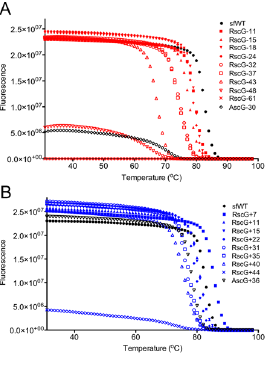
Figure 9. Stability measurements using thermal denaturation while monitoring GFP fluorescence. A) negative-charge variants. B) positive-charge variants. Rosetta-based designs retain thermostabil- ity within 10 u C of sfWT, except for the variants requiring severe mutagenesis ( . 33 mutations).